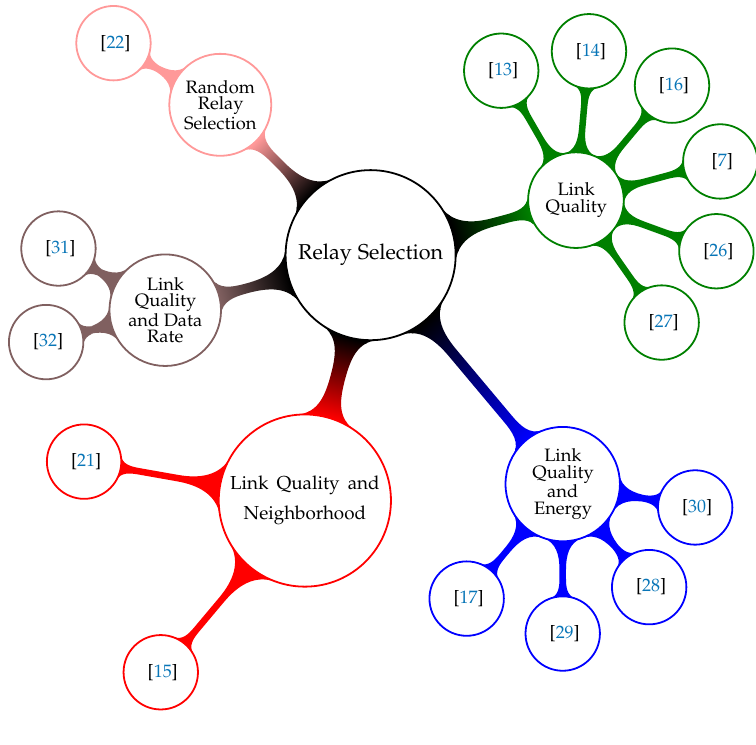
Figure 2. Relay selection categories based on the criteria used to select the cooperating